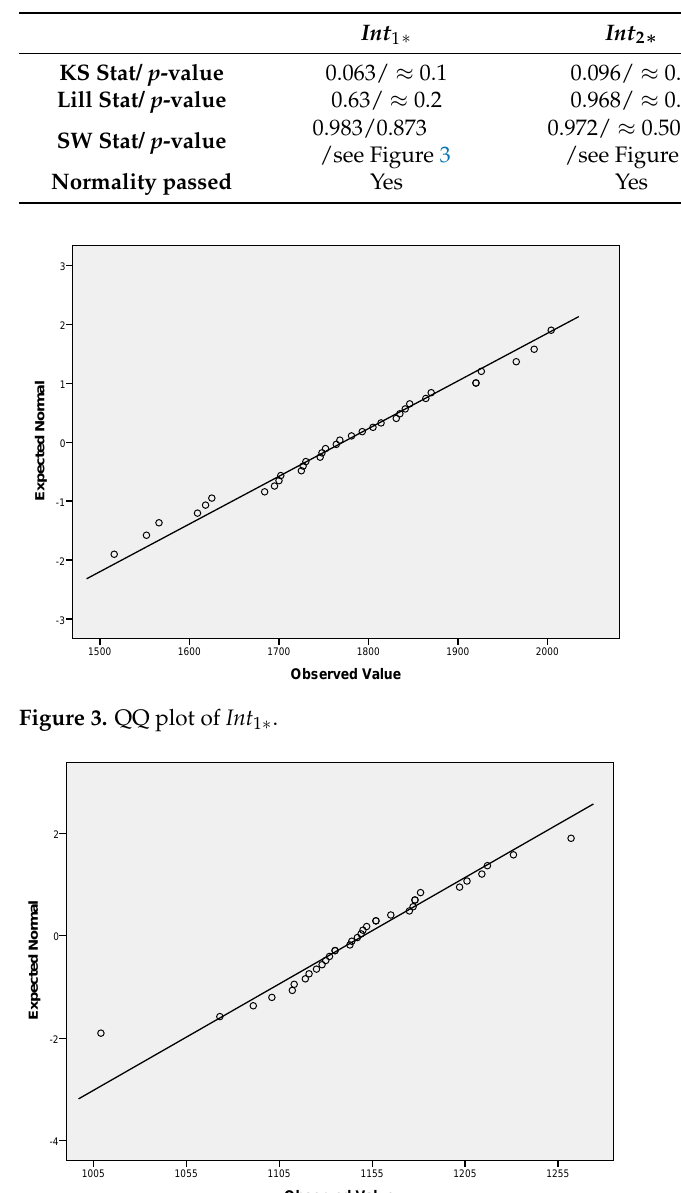
Table 7. Results of the normality testing Int 1 ∗ , Int 2 ∗ , Int 3 ∗ .